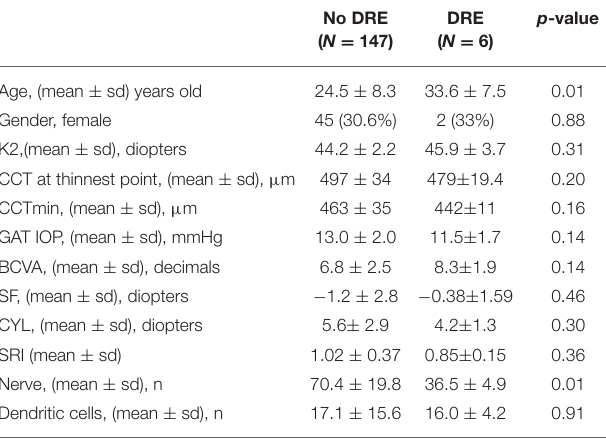
TABLE 1 | Demographic and clinical details for patients that